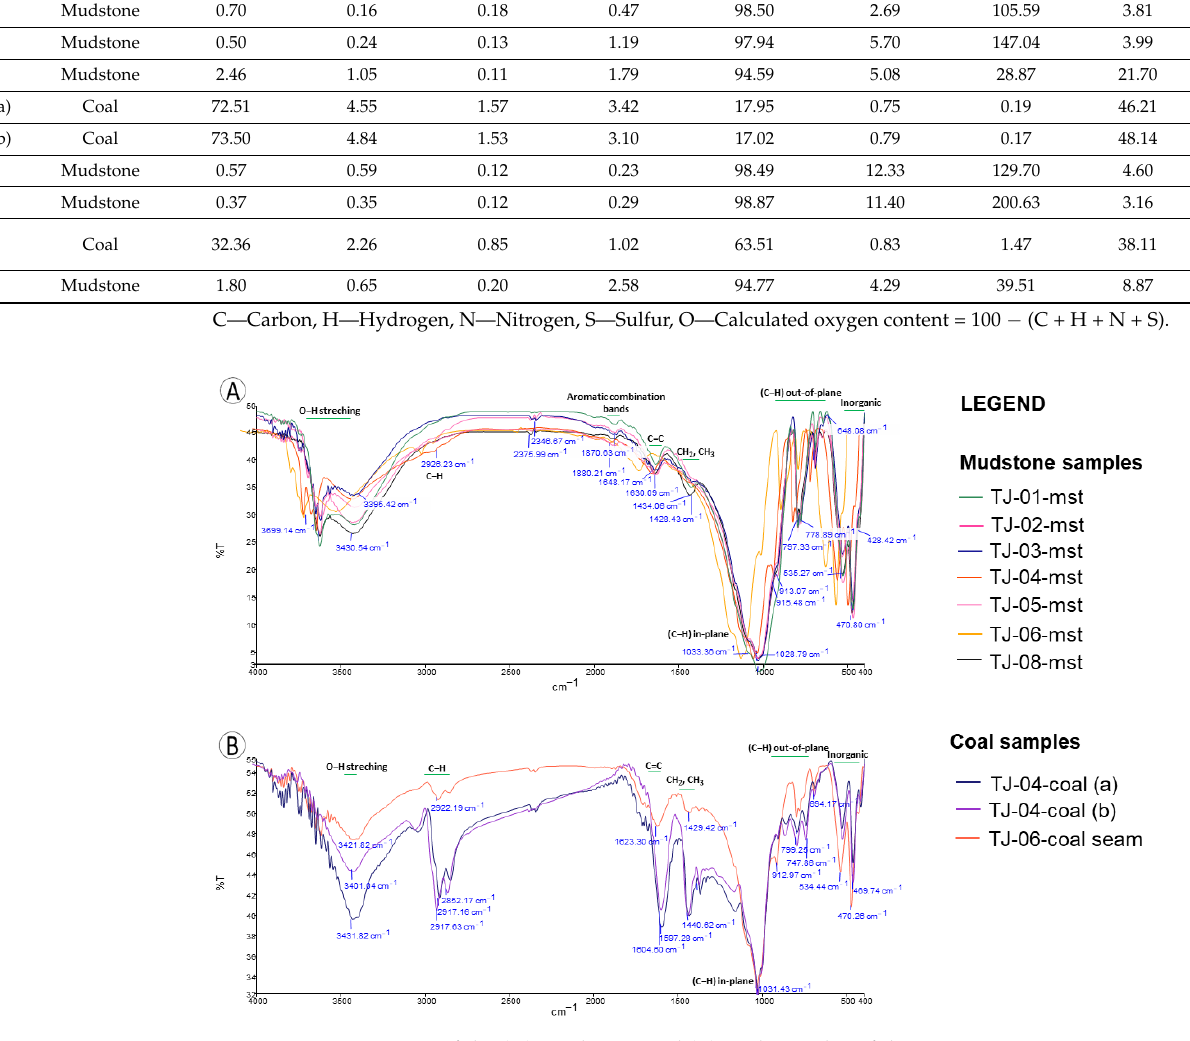
Figure 8. FTIR spectra of the ( A ) mudstone and ( B ) coal samples of the Tanjong Formation.